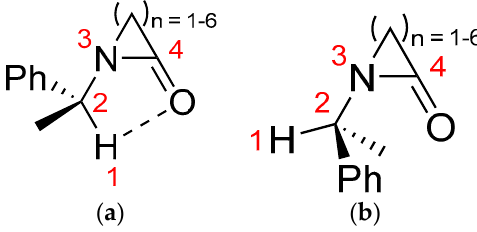
Figure 2. The dihedral angle Φ is formed by atoms H(1), C(2), N(3), and C(4). ( a ) Closed, when Φ presents values near 0.0°; and ( b ) open, when Φ presents values near 180°. Table 1. Dihedral angles and relative energies of open and close conformer.